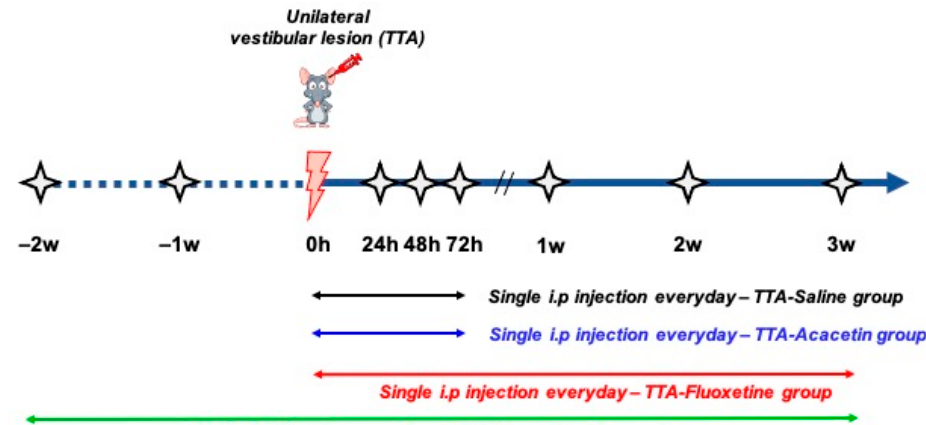
Figure 1. Study timeline of Fluoxetine, Acacetin and Saline groups. Assessment of central vestibular compensation was made through the analysis of the vestibular syndrome, behaviour and support surface. Each analysis was carried out at several time points: before the transtympanic injection (referred as pre-op), 24 h, 48 h, 72 h, 1 week, 2 weeks and 3 weeks after unilateral transtympanic injection of arsanilic acid.